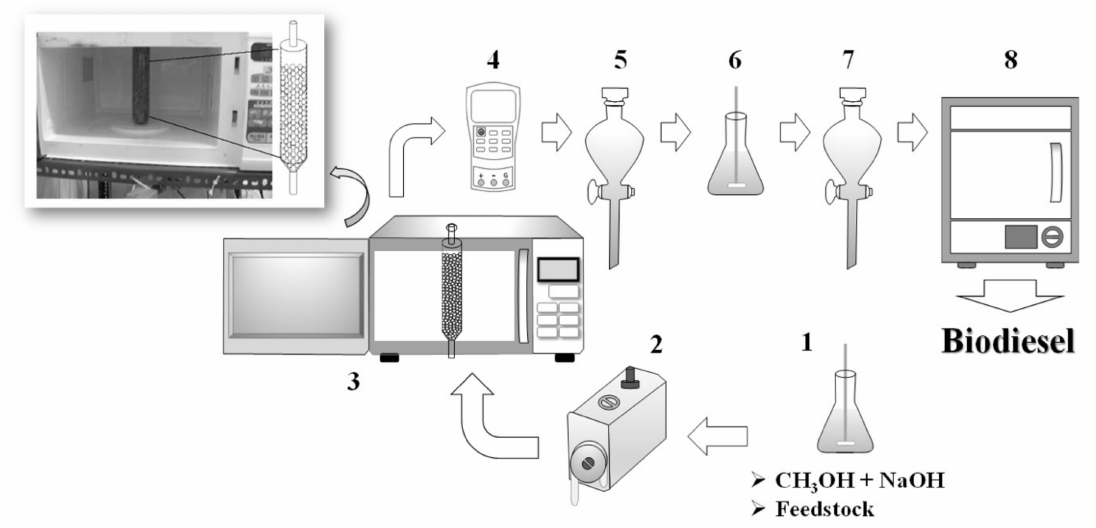
Figure 1. Schematic diagram of the microwave catalytic system. ( 1 ) mixing flask; ( 2 ) peristaltic pump; ( 3 ) microwave reactor; ( 4 ) thermometer; ( 5 ) separating funnel; ( 6 ) washing flask; ( 7 ) separating funnel; ( 8 )